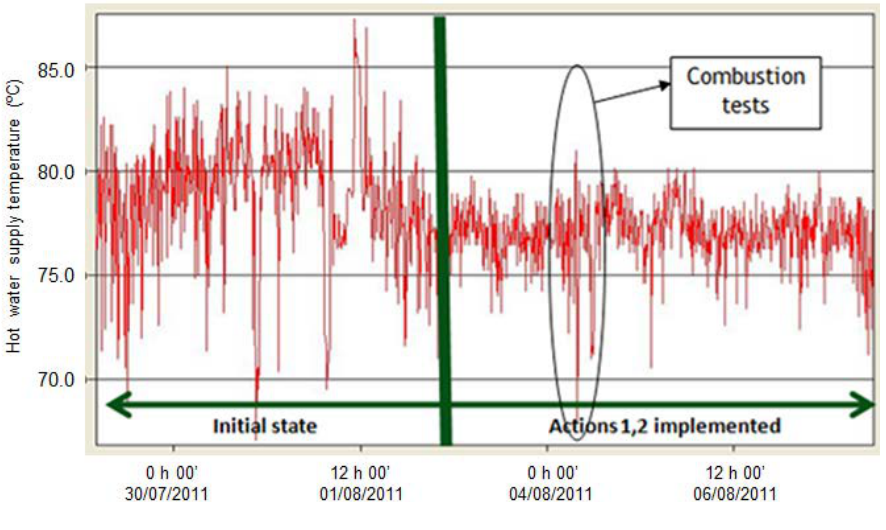
Figure 10. Boiler 5: Hot water supply temperature evolution (°C) implementing actions 1 and